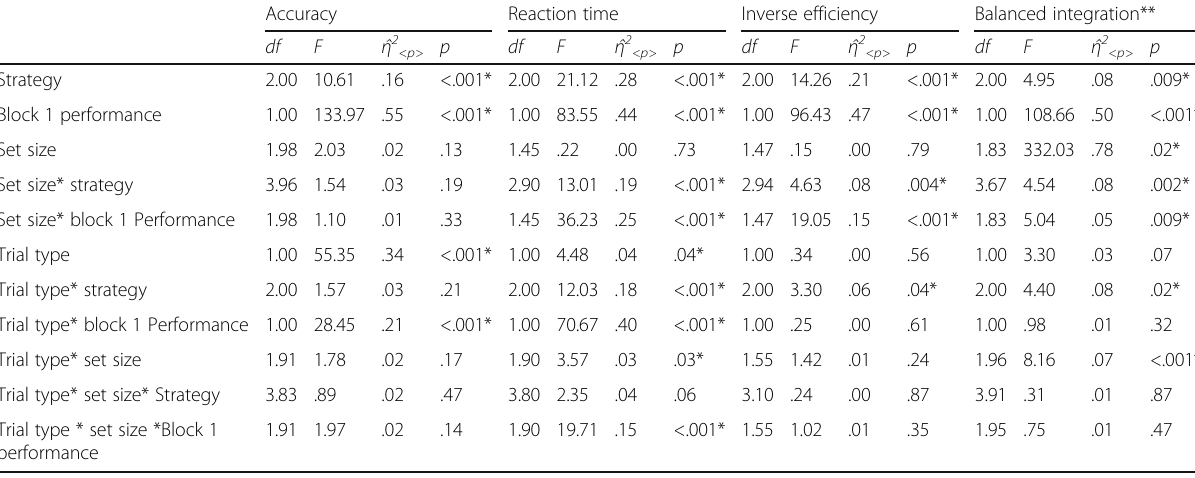
Table 1 Full results of analysis of covariance (ANCOVA) for experiment 1